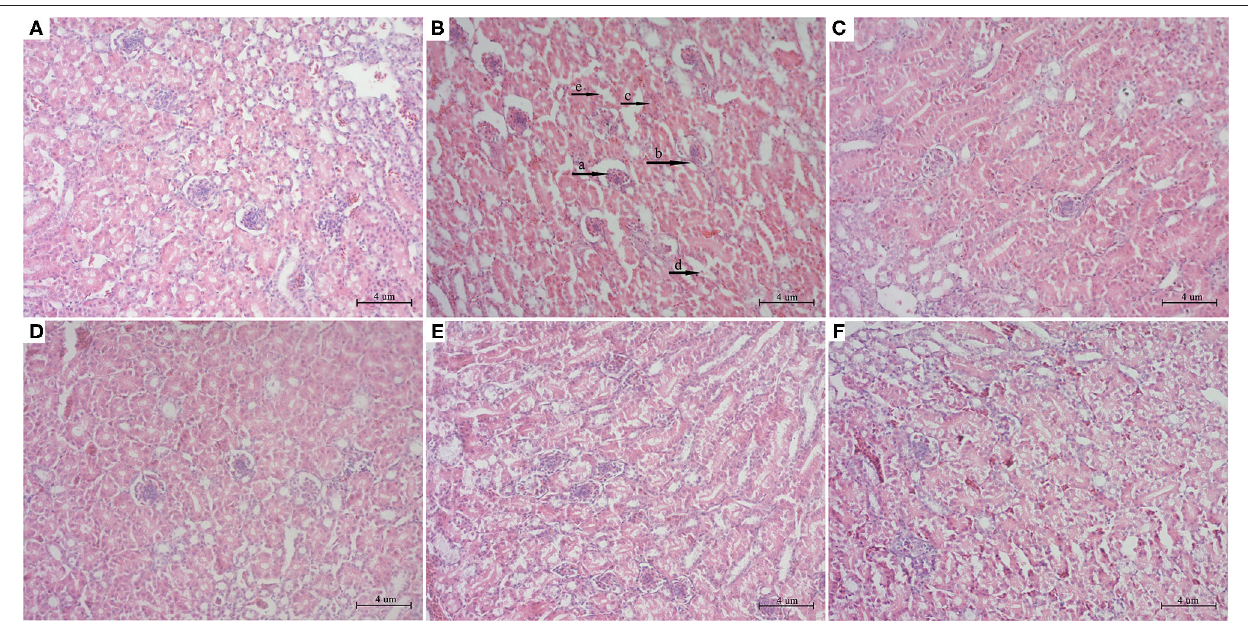
FIGURE 3 | Histopathological analysis of kidney from different groups. The kidney tissues were stained with H&E stain. (A) Control; (B) AFB1; (C) YCHT; (D) PCPC high dose; (E) PCPC medium dose; (F) PCPC low dose. (a) glomerulus atrophy, (b) glomerular epithelial cell proliferation, (c) renal tubular lumen stenosis and obscurity, (d) renal tubular epithelial cell shedding.